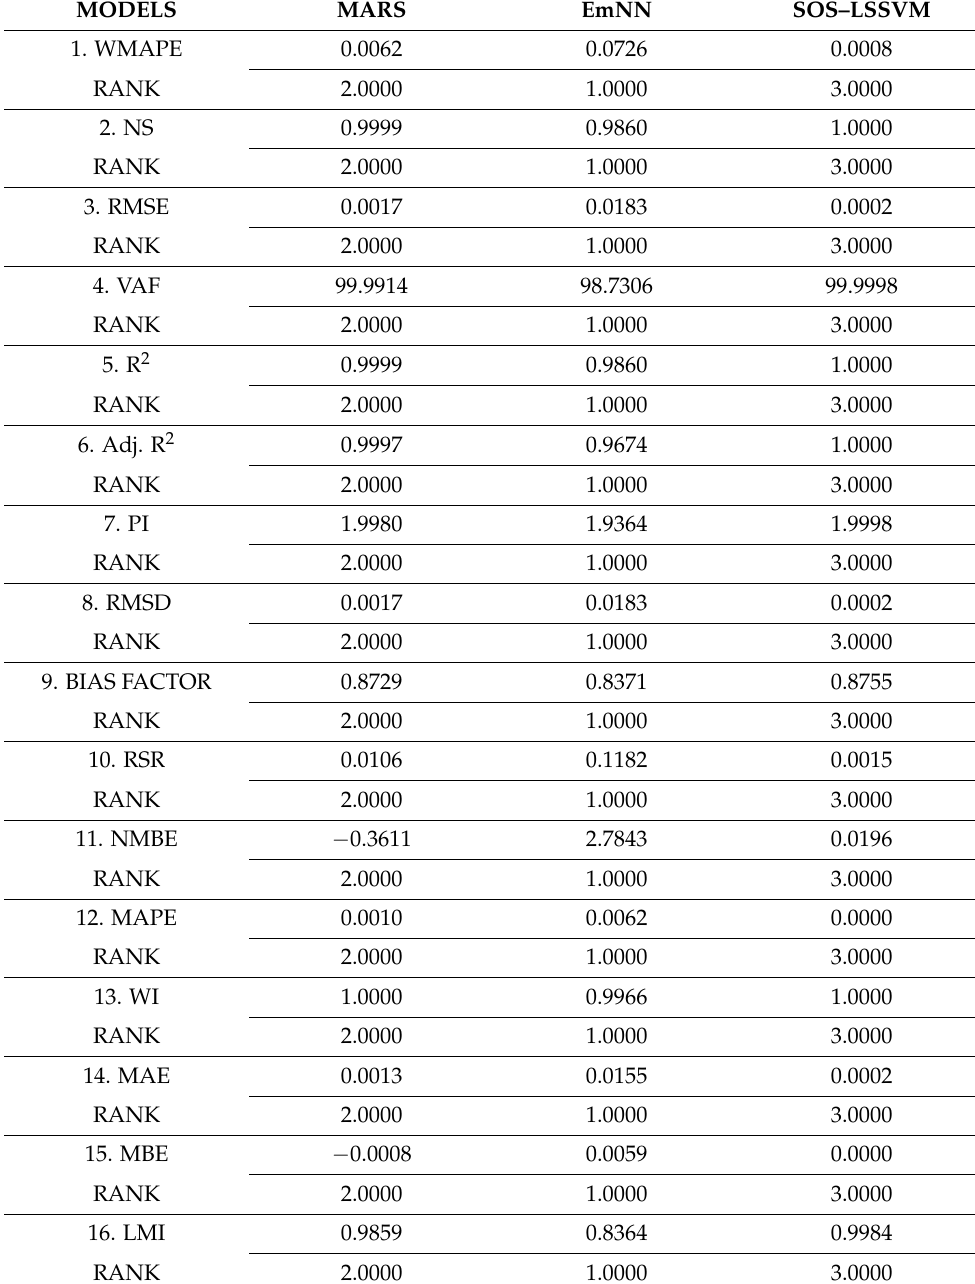
Table 1. Performance evaluation of applied methods via various error measurements